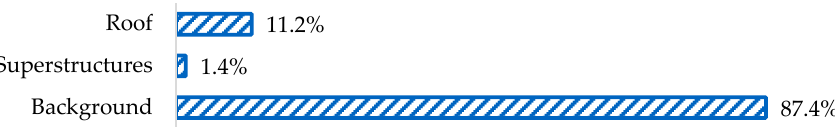
Figure 4. Representation of the class imbalance in the dataset.